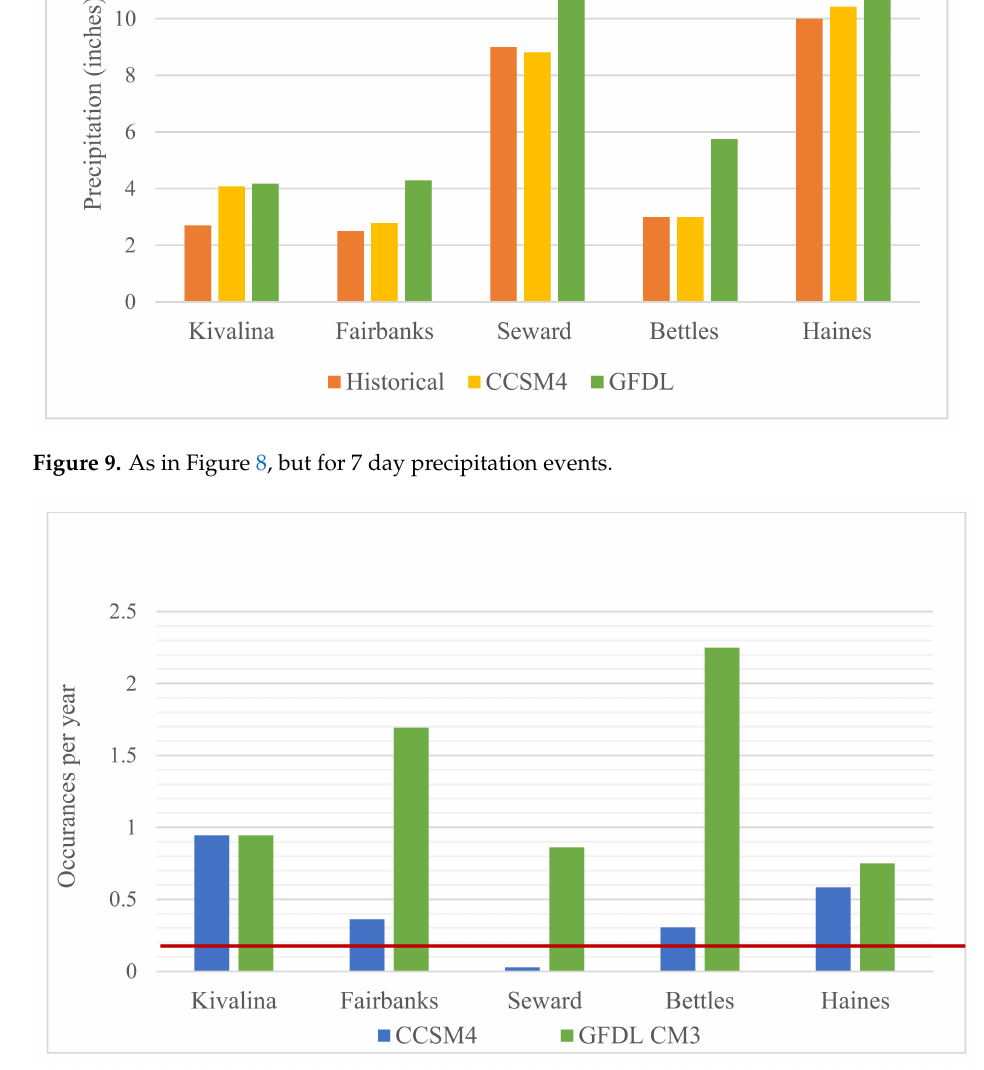
Figure 10. Projected changes of the number of exceedances of historical 3 day/5 year